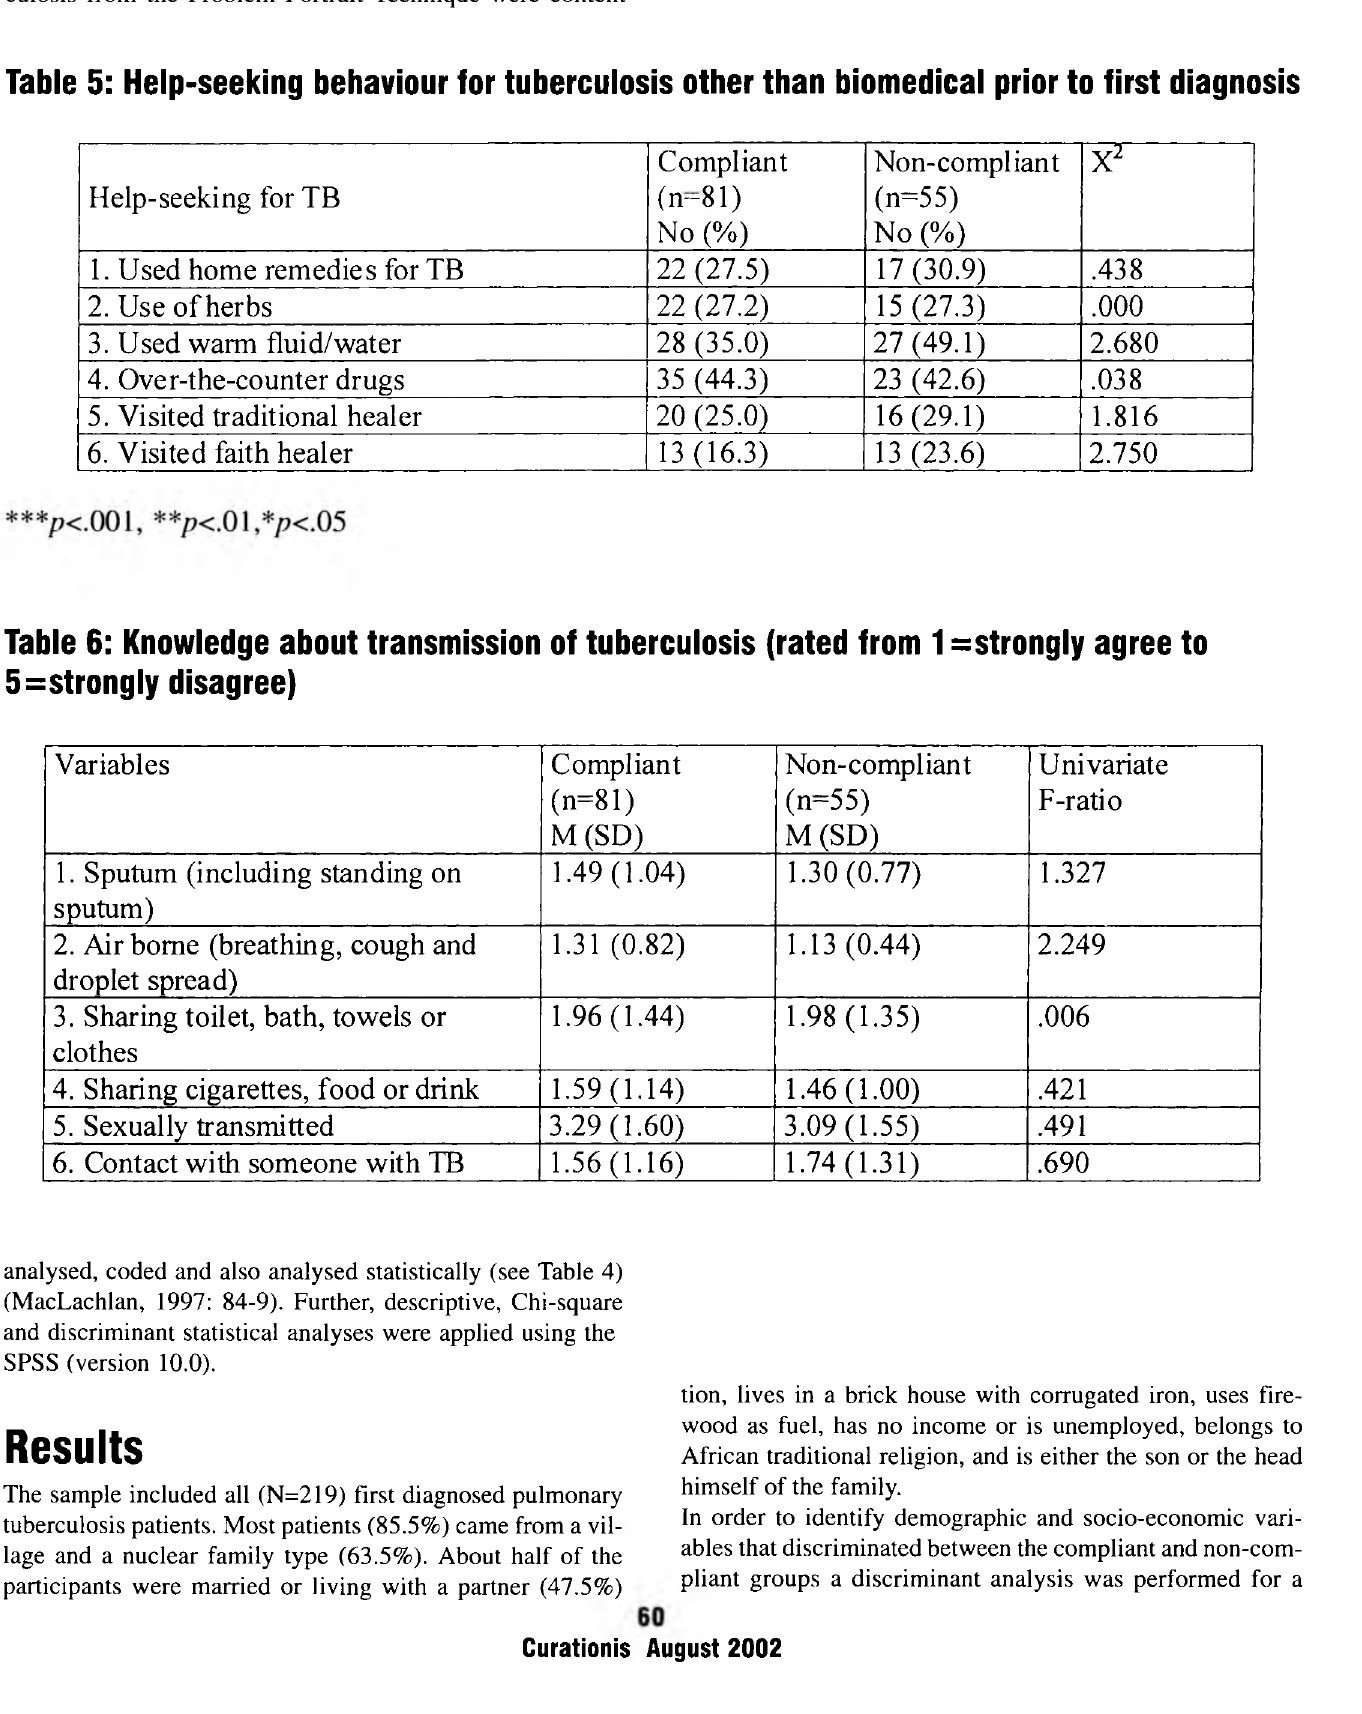
Table 5: Help-seeking behaviour for tuberculosis other than biomedical prior to first diagnosis